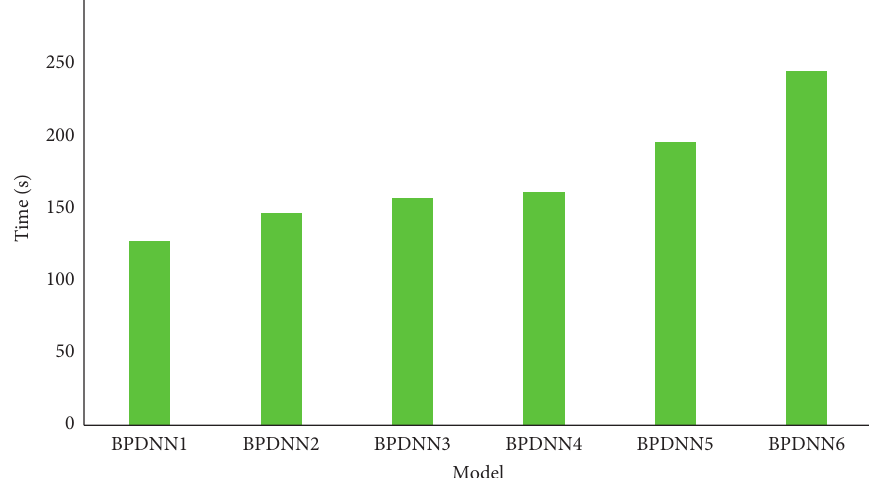
Figure 4: Processing time of the back-propagation-based model.